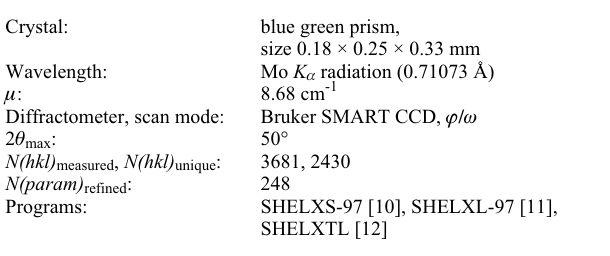
Table 1. Data collection and handling.